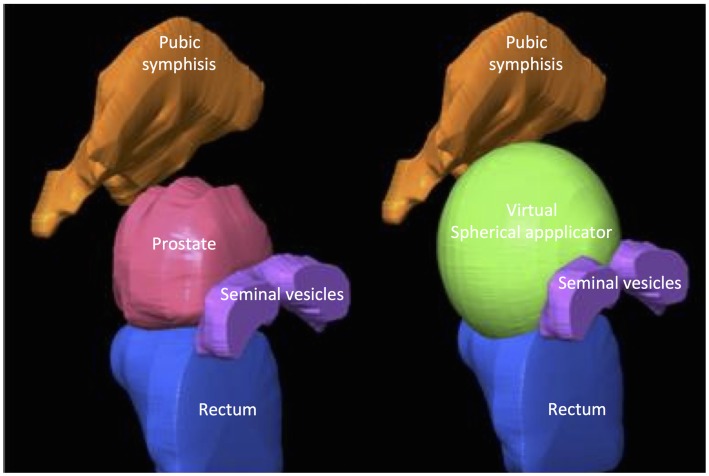
Graphical representation of the determination of applicator size on MRI images.